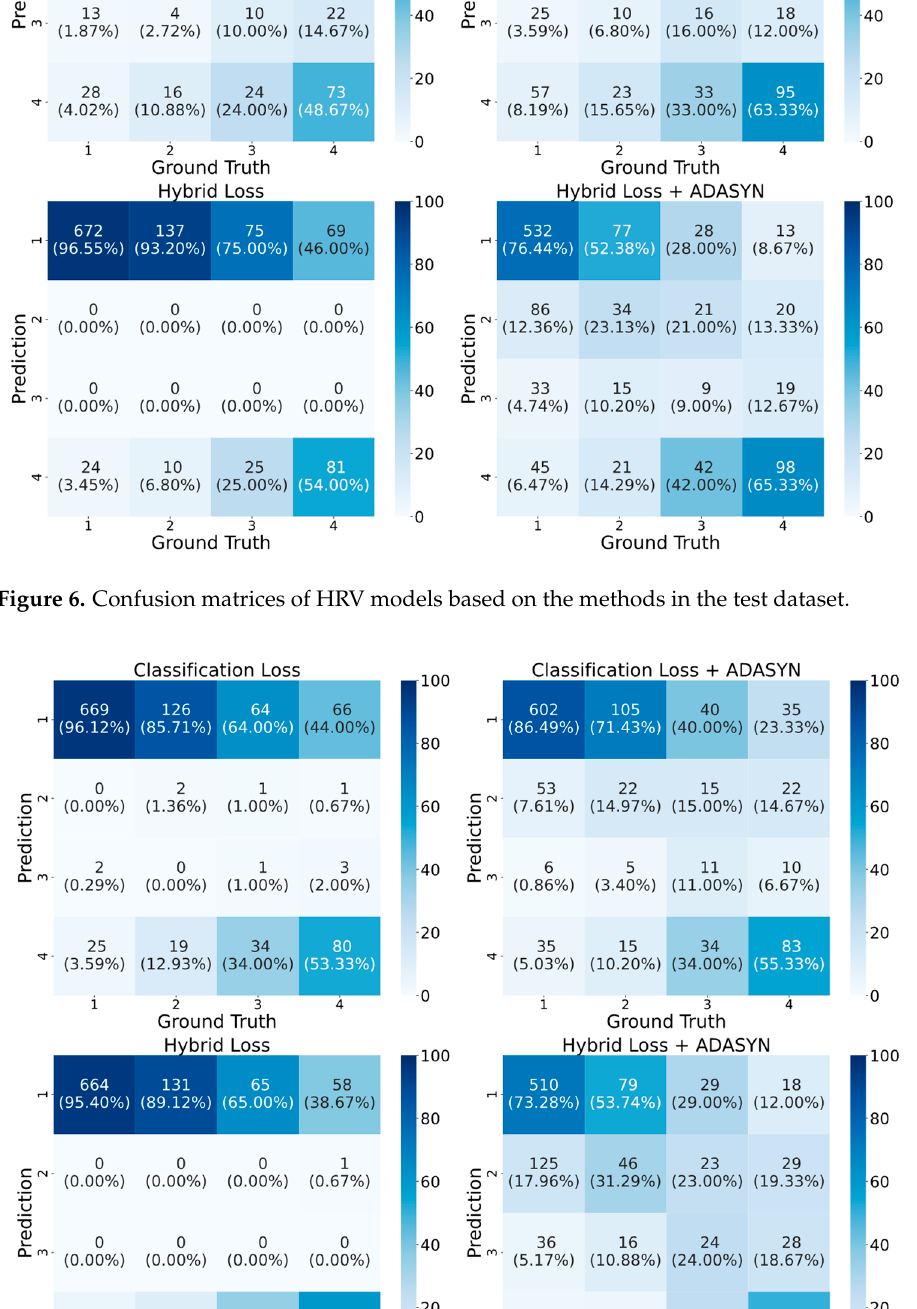
Figure 8. Confusion matrices of combined models based on the methods in the test dataset.